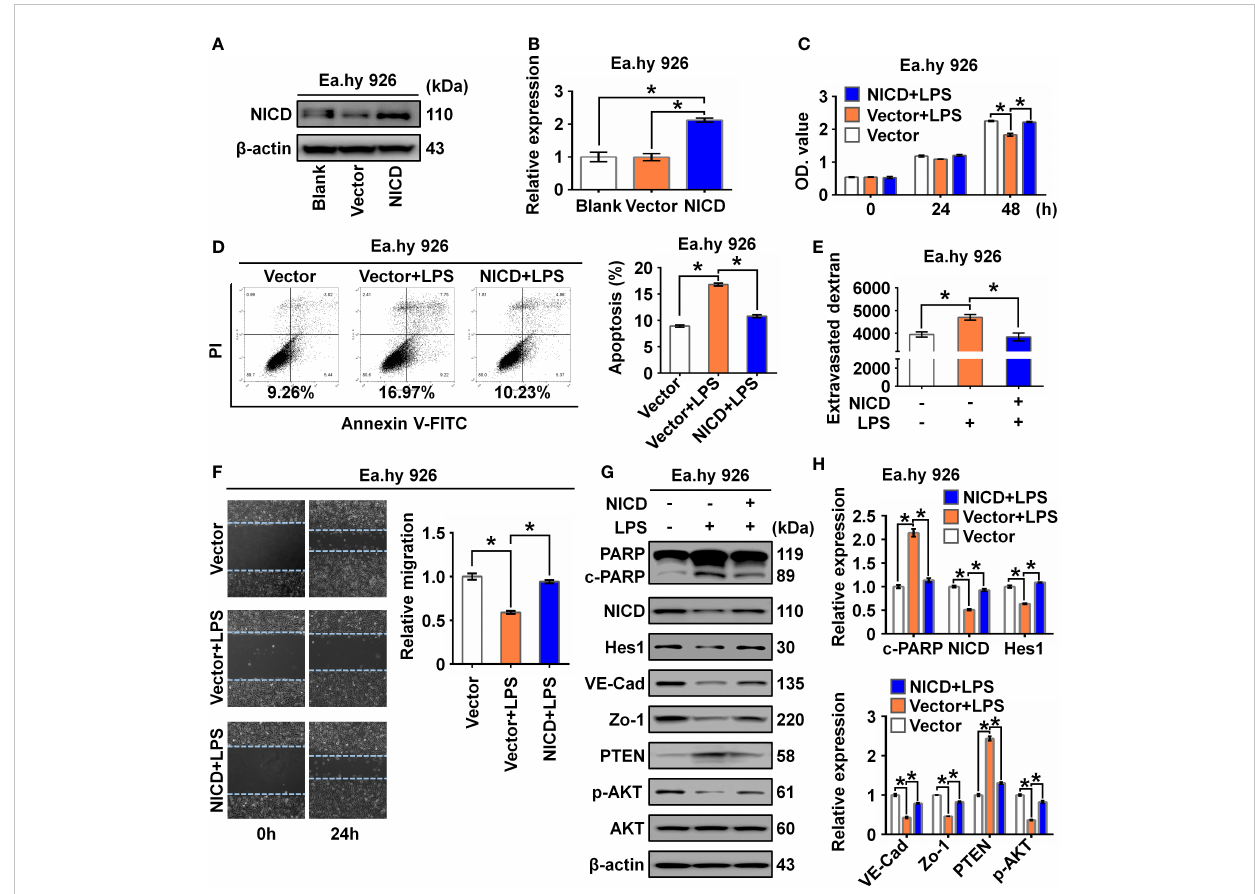
FIGURE 3 Overexpression of NICD reversed LPS-caused endothelial dysfunction. (A, B) The expression of NICD in Ea.hy 926 cells was tested by Western blot after transfected with blank plasmids, vector or NICD plasmids. Representative images (A) and three experiments replicates (B) were displayed. (C) CCK8 assay was used to evaluate the proliferation of Ea.hy 926 cells treated with the indicated conditions. (D) The apoptosis of Ea.hy 926 cells treated with indicated conditions was tested with Annexin V-FITC/PI staining by fl ow cytometry. Representative images (D) -left) and statistical analysis of apoptosis (D) -right) for Ea.hy 926 cells transfected by blank plasmids, vector or NICD plasmids after LPS treatment were shown. (E) The endothelial permeability was determined by the transwell assay after being treated with the indicated conditions. (F) The migration of Ea.hy 926 cells was tested by wounding healing assay. Representative images (F) -left) and statistical analysis of migration (F) -right) for Ea.hy 926 cells transfected by blank plasmids, vector or NICD plasmids after LPS treatment were shown. (G, H) The protein levels of cleaved PARP, NICD, Hes1, VE-Cad, Zo-1, PTEN, and p-AKT was tested in LPS-treated Ea.hy 926 cells with or without NICD-transfected. Representative images (G) and three experiments replicates (H) were displayed. The data were obtained from three independent experiments. Data are shown as the mean ± SEM. * p <